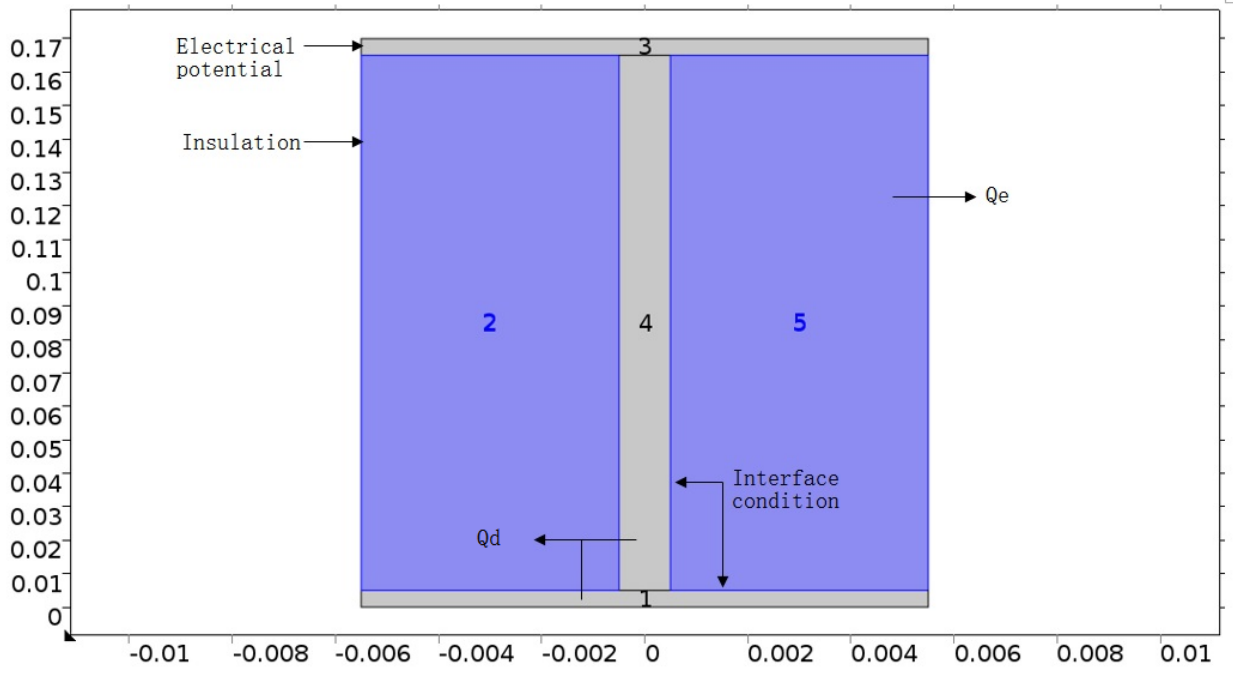
Figure 4. FEM boundary conditions, x-axis is the bus-bar direction (m) and y-axis is the finger direction